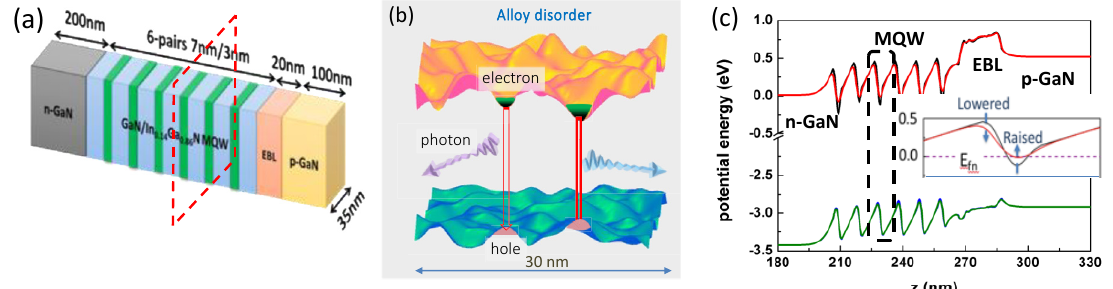
Figure 2: (a) Schematics of the blue-emitting LED to be modeled with 3-nm thick In o.14 Ga 0.86 N quantum wells (QWs) and 7-nm thick GaN barriers; (b) in-plane disordered electron and hole effective energy levels computed with the localization landscape (LL) theory (see below). The emission energy observed at the nanoscale of disorder should reveal the local disordered-localization energy; (c) in-plane averaged, computedbandextremaalongthegrowthdirectionunder2.8Vforwardbias.Blackcurvesshowtheaveragedbandextremaobtainedfromthe compositional map,whereasthe red andgreencurvesshow the averagedbandextrema computedthroughthe LLtheory. The insetshowsthe effect of quantum disorder, raising and lowering energy extrema due to in-plane quantum con fi nement and tunneling (from